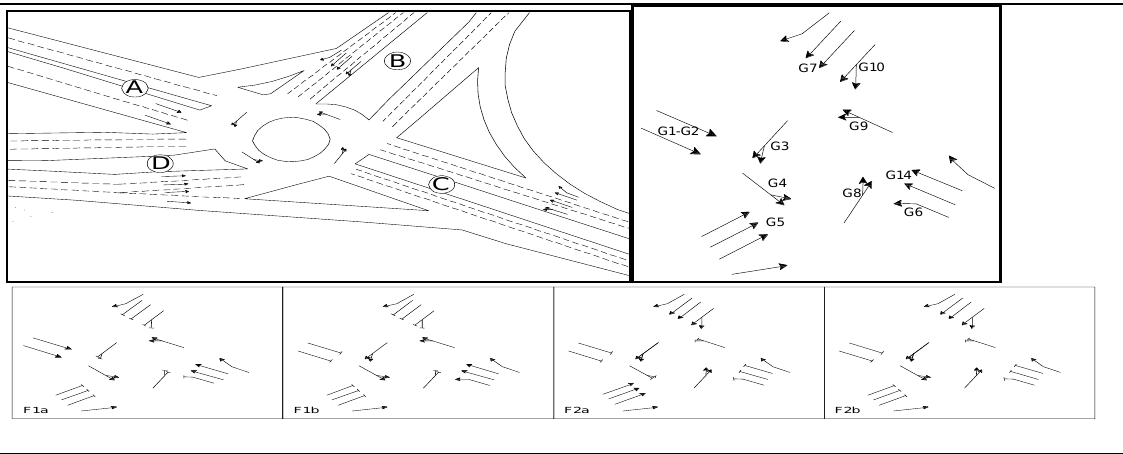
Figure 2. Lanes on the approach arms of K1 intersection and traffic flow directions